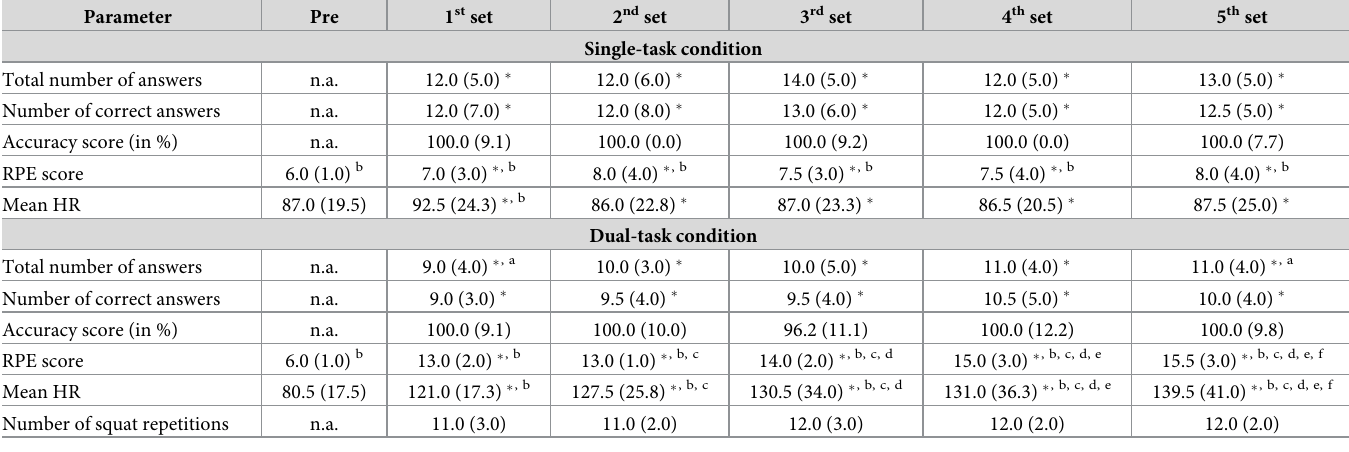
Table 2. Median (interquartile range) of cognitive measures and RPE in single-task condition and dual-task condition are shown. Additionally, the number of repeti- tions of barbell back squats in dual-task condition is presented. Parameter Pre 1 st